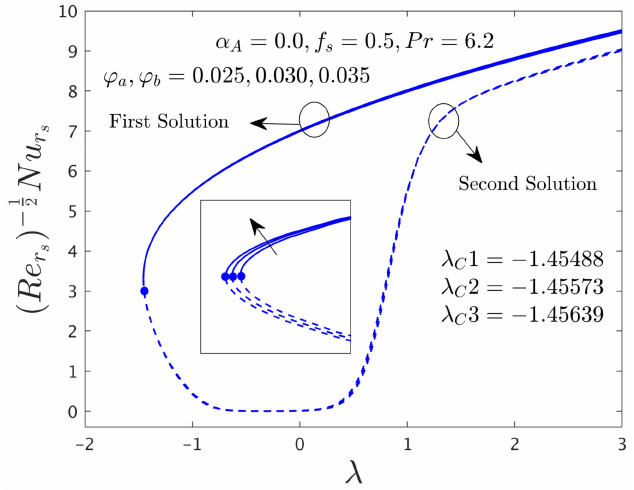
Nu r against λ for numerous choices of hybrid nanoparticles. s s